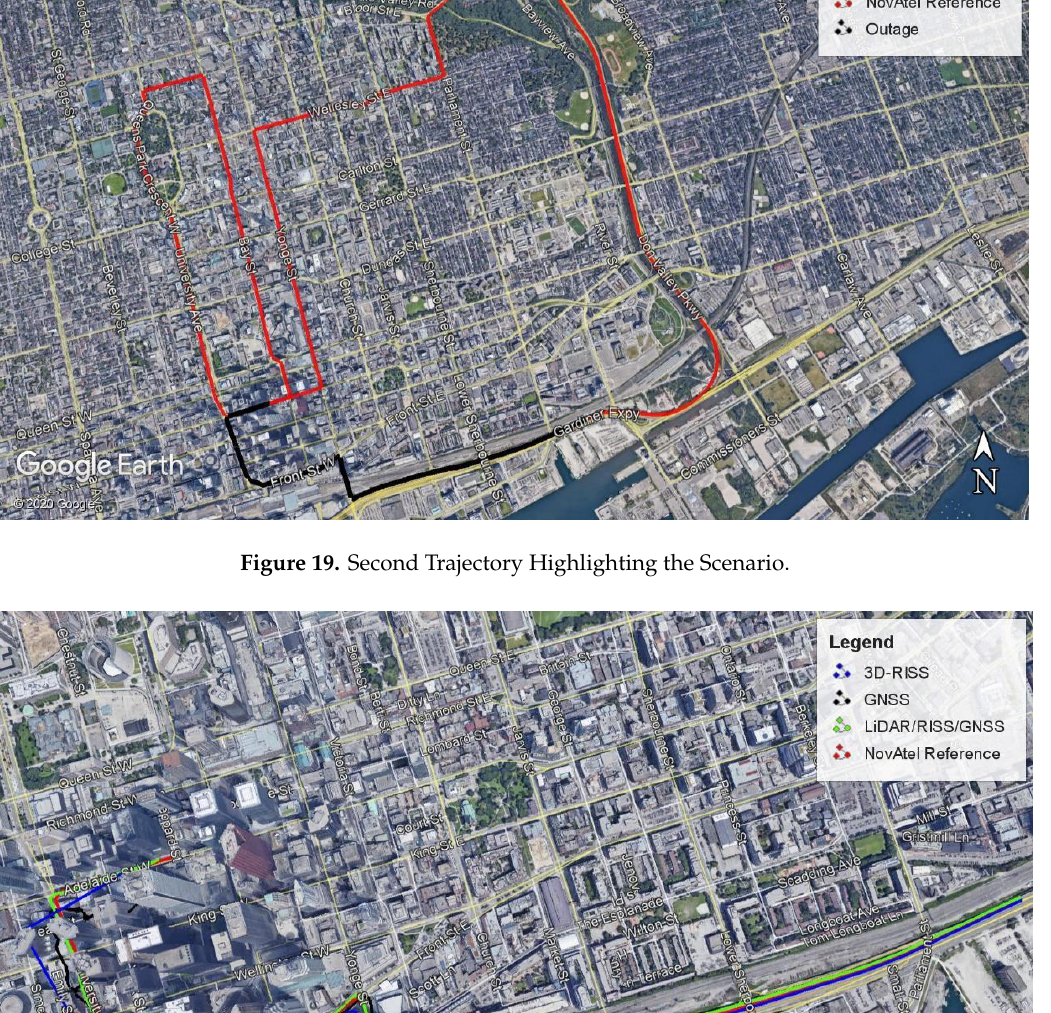
Figure 19. Second Trajectory Highlighting the Scenario.